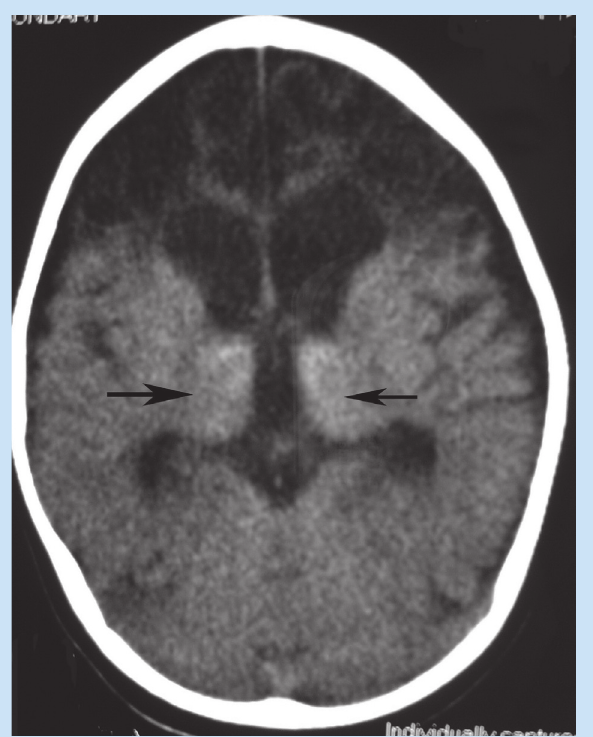
Fig. 2.4c. In addition to the anterior watershed subcortical cystic change and volume loss, there is increased density of the thalami (arrows) repre- senting mineral deposition (calcification) in this area, known for its suscep- tibility to